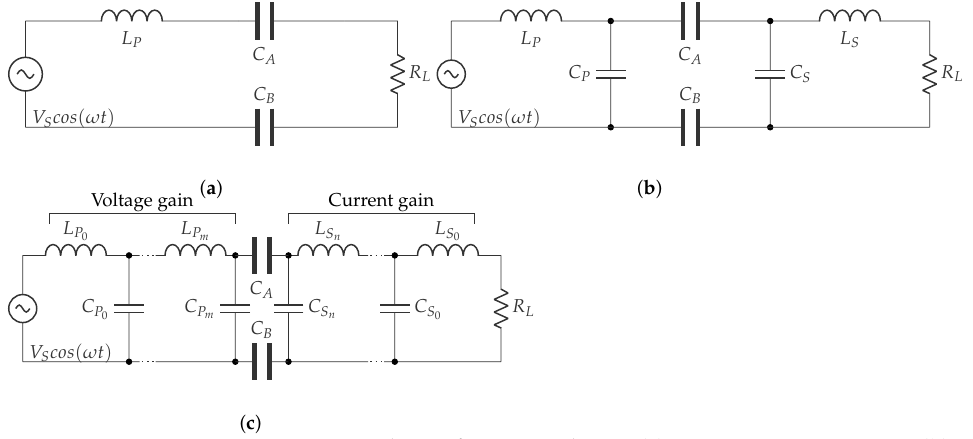
Figure 16. Compensation circuit topologies for practical CPT. ( a ) L-compensation circuit. ( b ) LC- compensation circuit. ( c ) Multistage L-section compensation circuit.